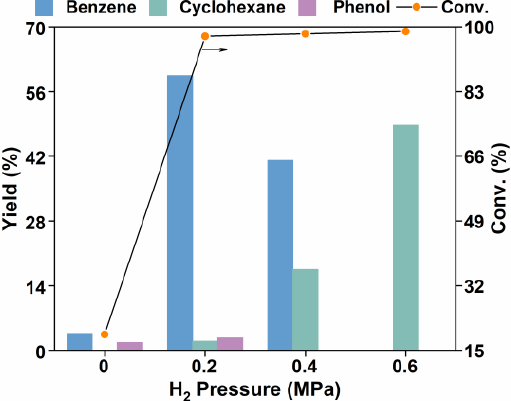
Figure 8. Influence of initial H 2 partial pressure on the distribution of products.